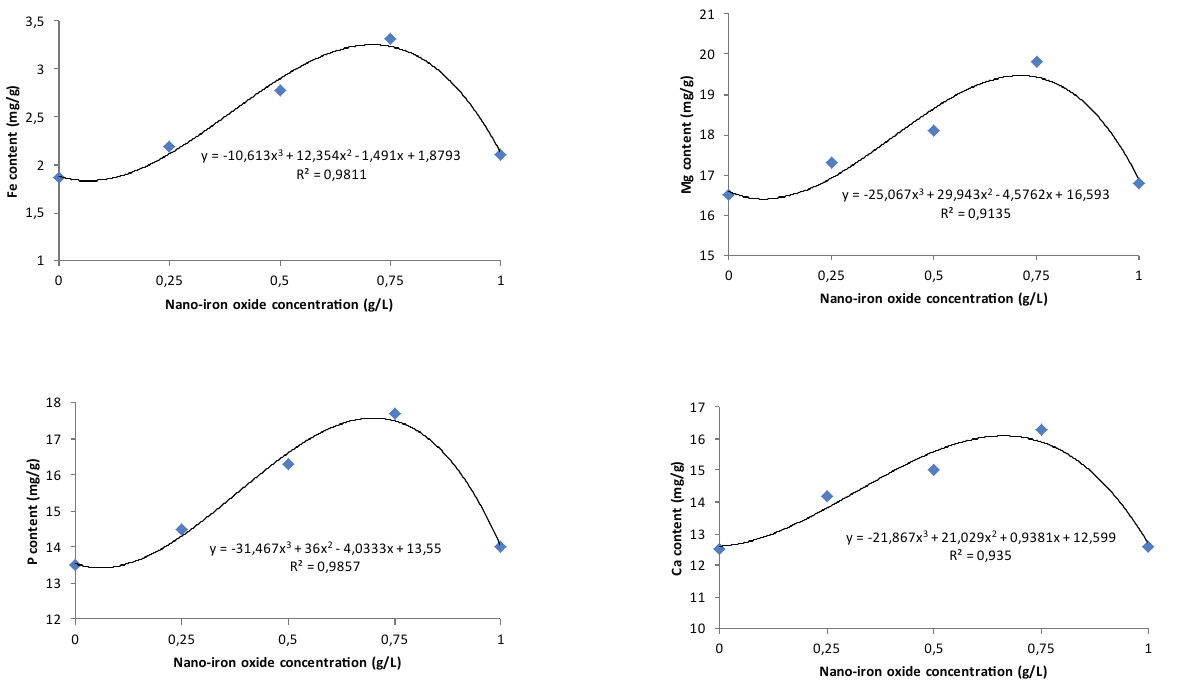
Nano-iron oxide concentra � on (g/L)